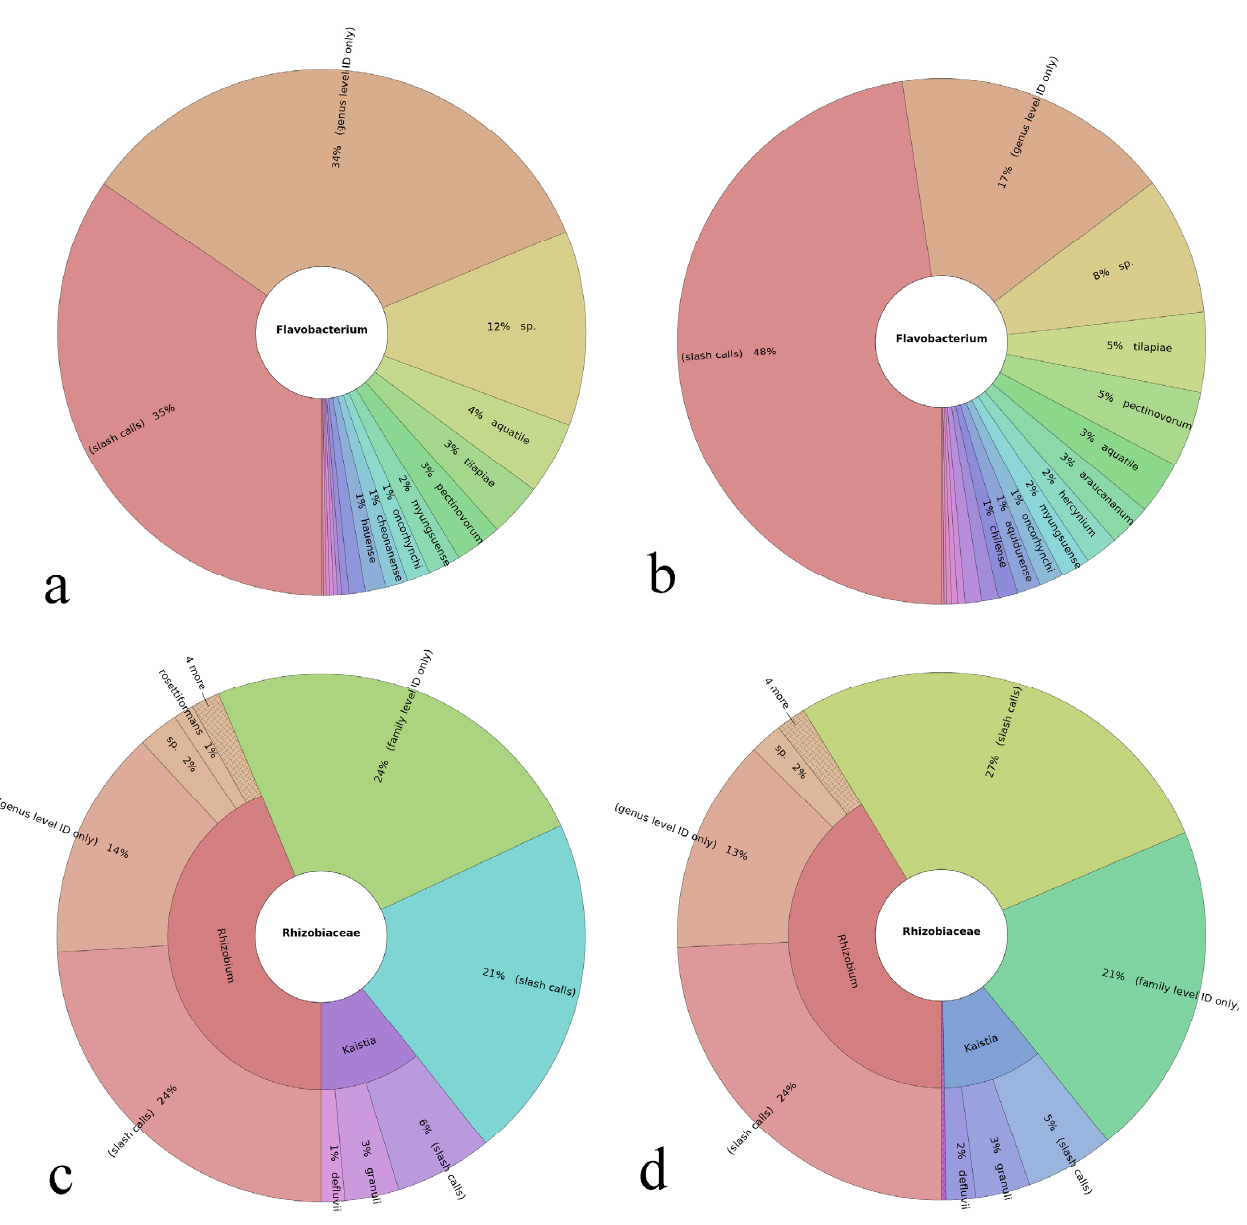
Figure 10. Krona plots focused on the Flavobacterium genus ( a , b ) and the Rhizobiaceae family ( c , d ) correlating positively with plant growth for the untreated ( a , c ) and treated ( b , d ) soil samples.